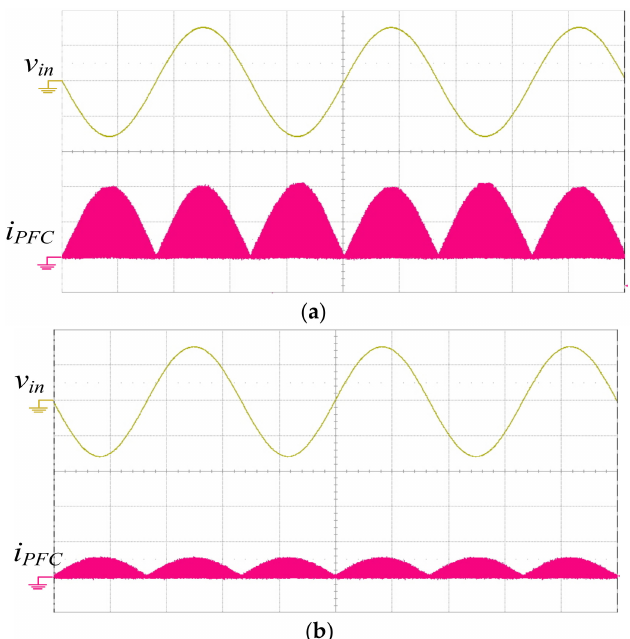
Figure 9. Waveforms of the input voltage and PFC inductor current. ( a ) 100% and ( b ) 4% rated power. ( v in : 100 V / div, i PFC : 1 A / div, Time: 5 ms / div).